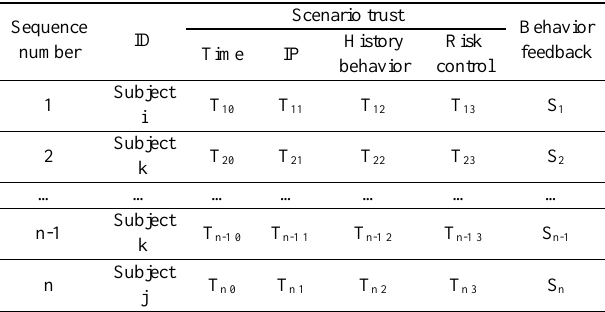
Table 3. Access record table